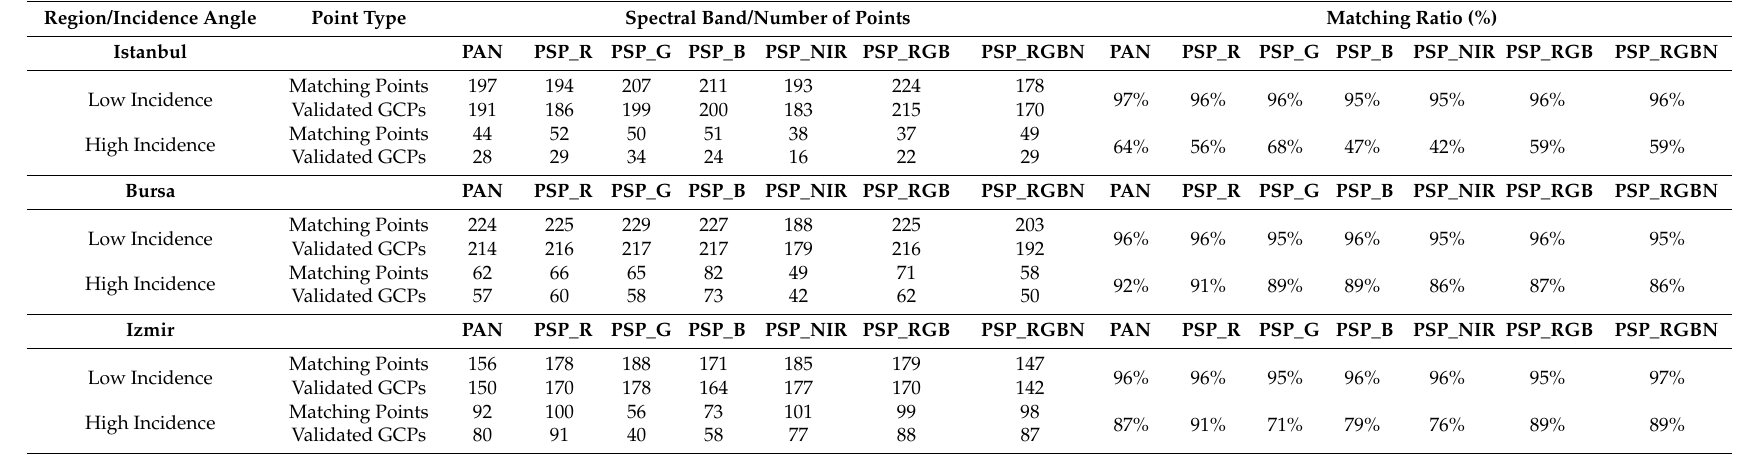
Table A1. Statistical comparison of matching points and validated GCPs derived from these points after outlier removal. Region/Incidence